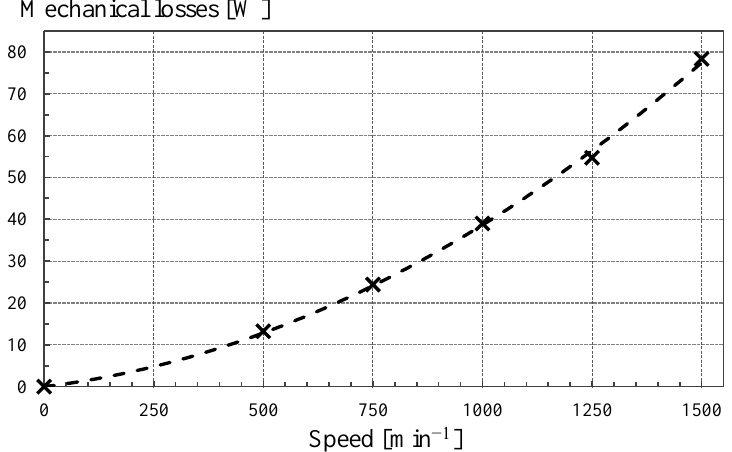
Figure 1. Dependence of the measured mechanical losses on speed for a cold motor. Crosses: measured data; and dashed curve: second-order polynomial fit.